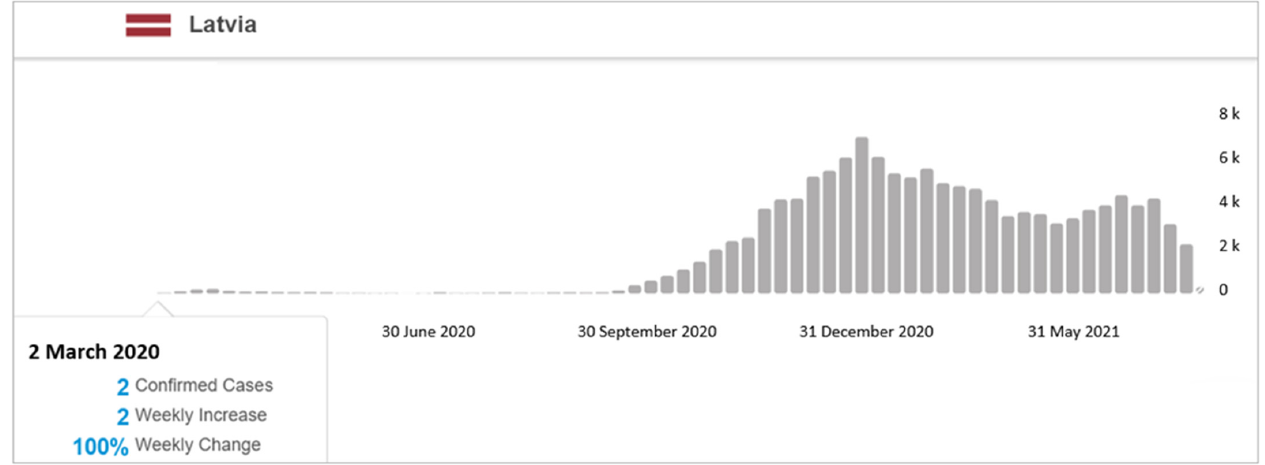
Figure 1. World Health Organisation Coronavirus (COVID-19) Dashboard, confirmed cases in Latvia, March 2020–May 2021 [4].